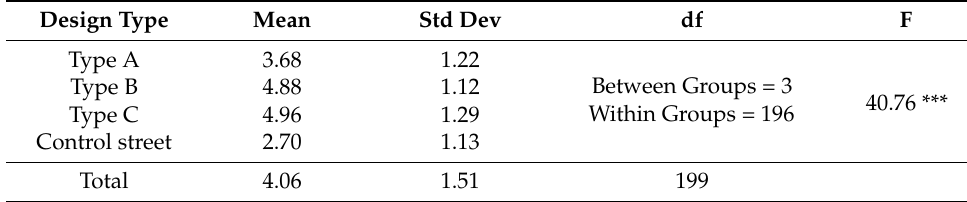
Table 4. One-way ANOVA results for participants’ perceived